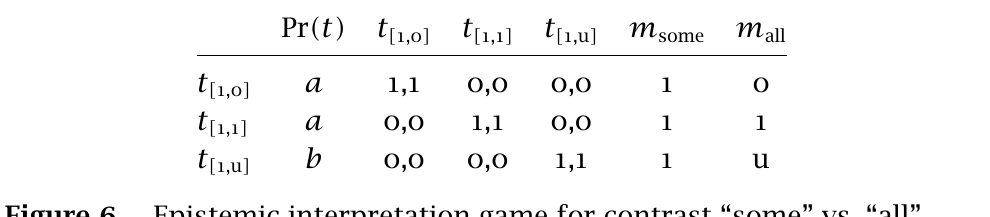
Figure 6 Epistemic interpretation game for contrast “some” vs.